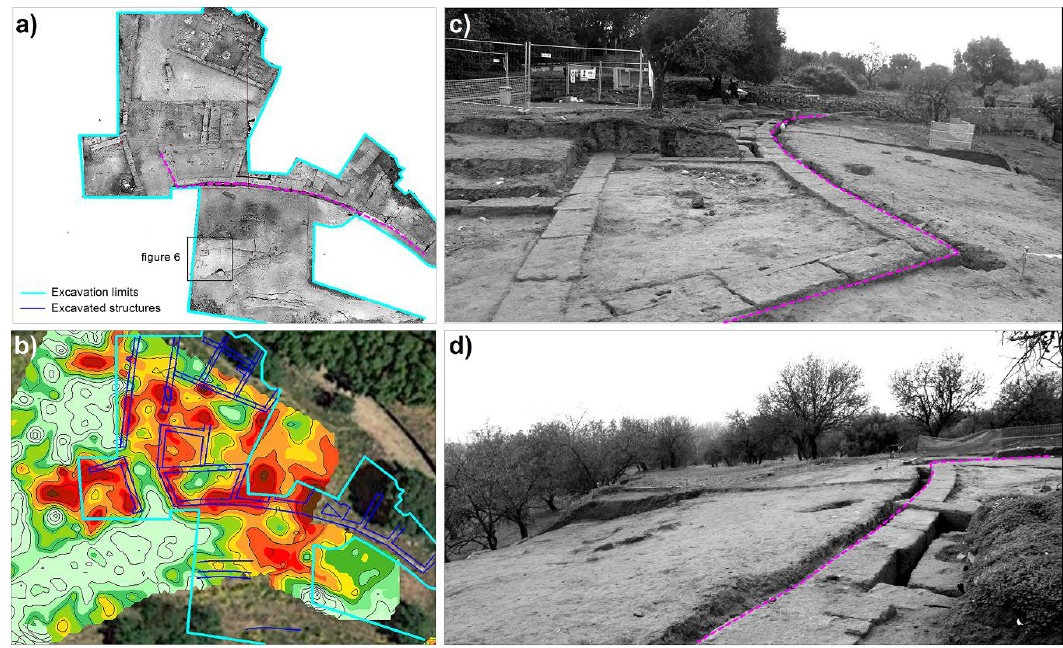
Figure 7. Orthophoto of the archaeological excavation in the northern sector of the theater (elaboration by A. Fino) ( a ), overlay of the relief of the structures on the resistivity map ( b ), the curvilinear wall that delimits the system of connecting rooms seen from the East ( c ) and the foundation pit with a curvilinear pattern and the foundation walls of the theatrical structures seen from the west ( d ).